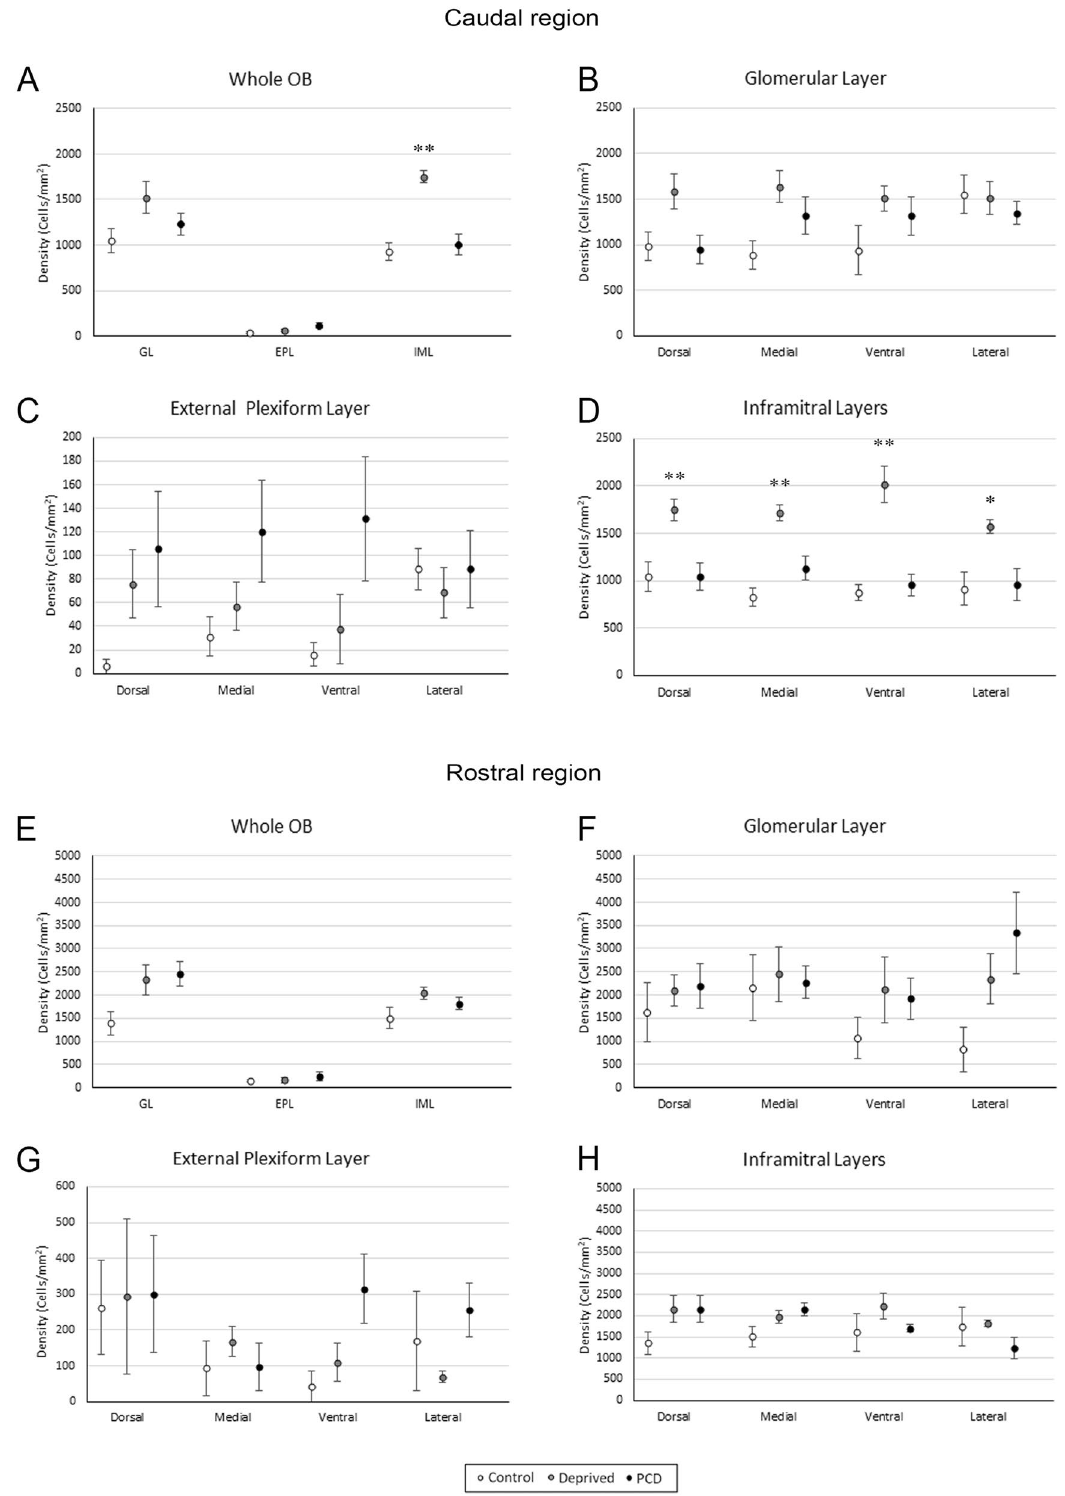
Figure 3. Quantification of SCGN expression in the caudal ( A – D ) and rostral levels ( E – H ) of the OB. The graphs show the variation in cell density within the glomerular layer (GL), the external plexiform layer (EPL) and inframitral layers (IML) in control (white), deprived (gray) and PCD (black) mice. As can be observed, there are significant variations in the inframitral layers of deprived animals compared to the control mice in the caudal, whereas in the rostral level there are no significant differences. * p < 0.05, **p <